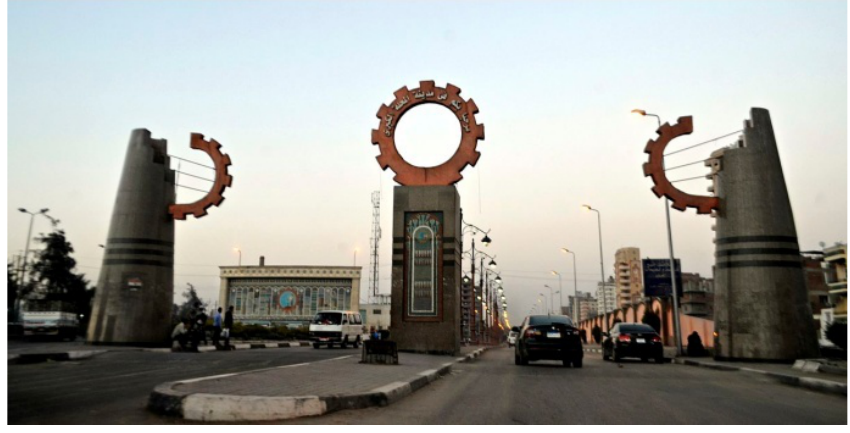
Fig. 18, Artwork structures (gears), Mahalla,